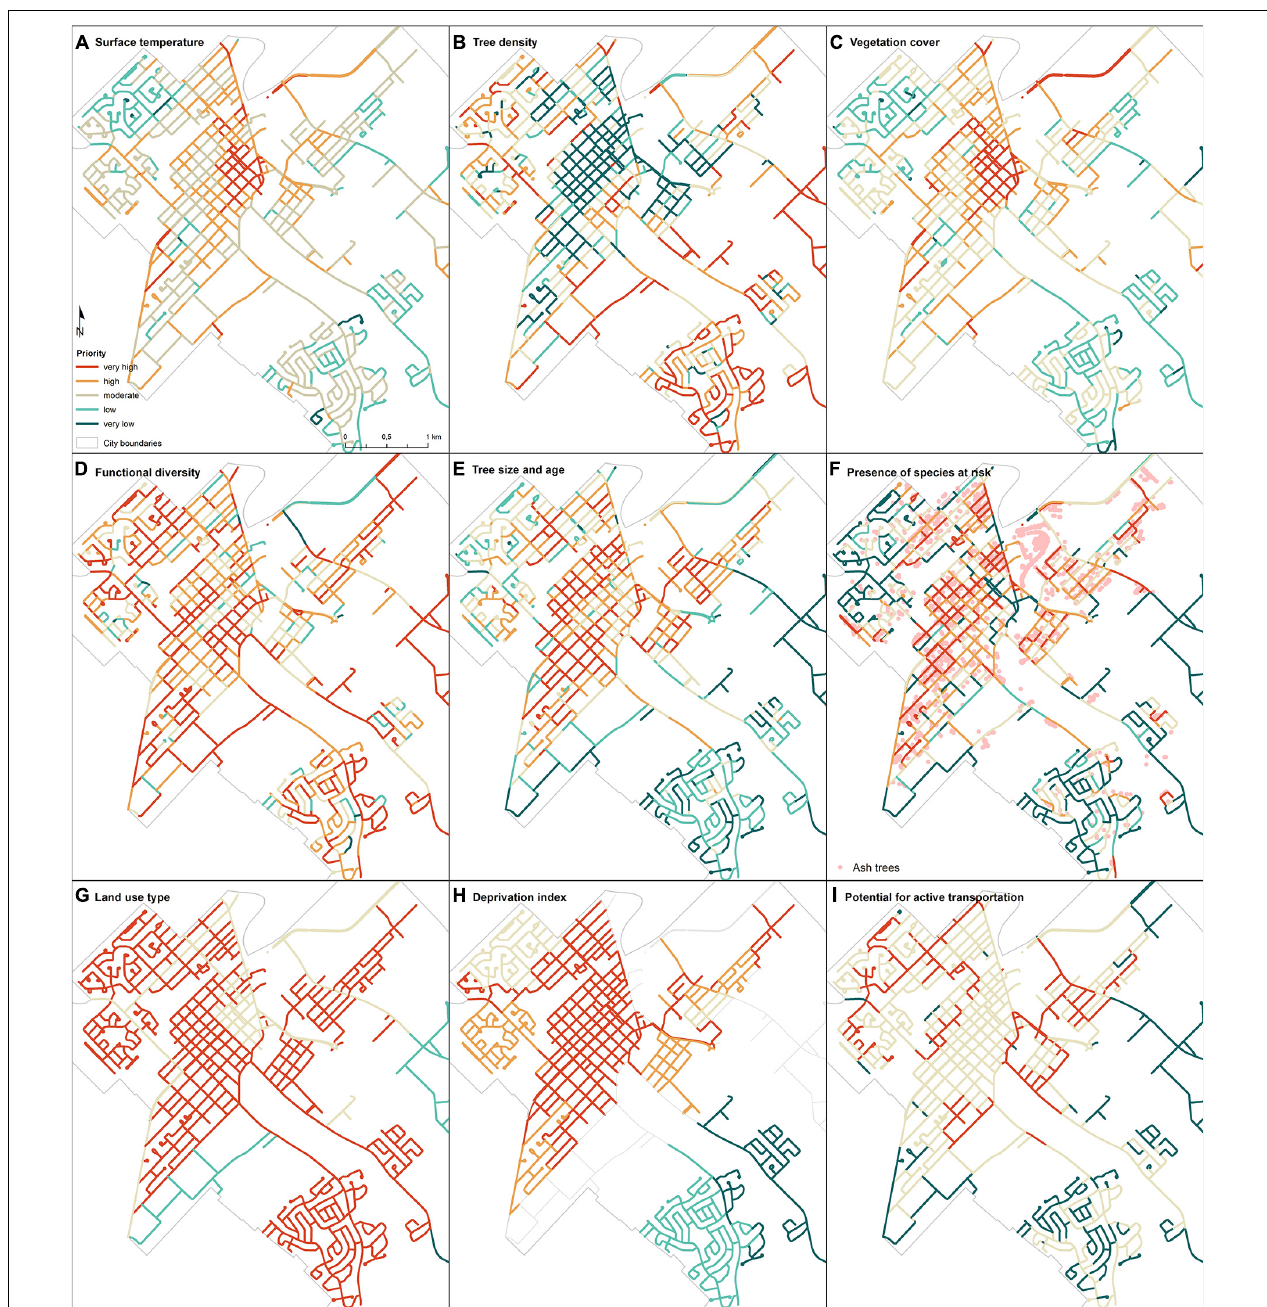
FIGURE 2 | Tree planting priority maps for the City of Joliette showing single-objective optimizations scenarios using the selected indicators: (A) surface temperature, (B) tree density, (C) vegetation cover, (D) tree functional diversity, (E) tree size and age, (F) presence of species at risk (ash trees), (G) land use type, (H) deprivation index, and (I) potential for active transportation. Street segments shown in red have a higher priority for planting (unweighted